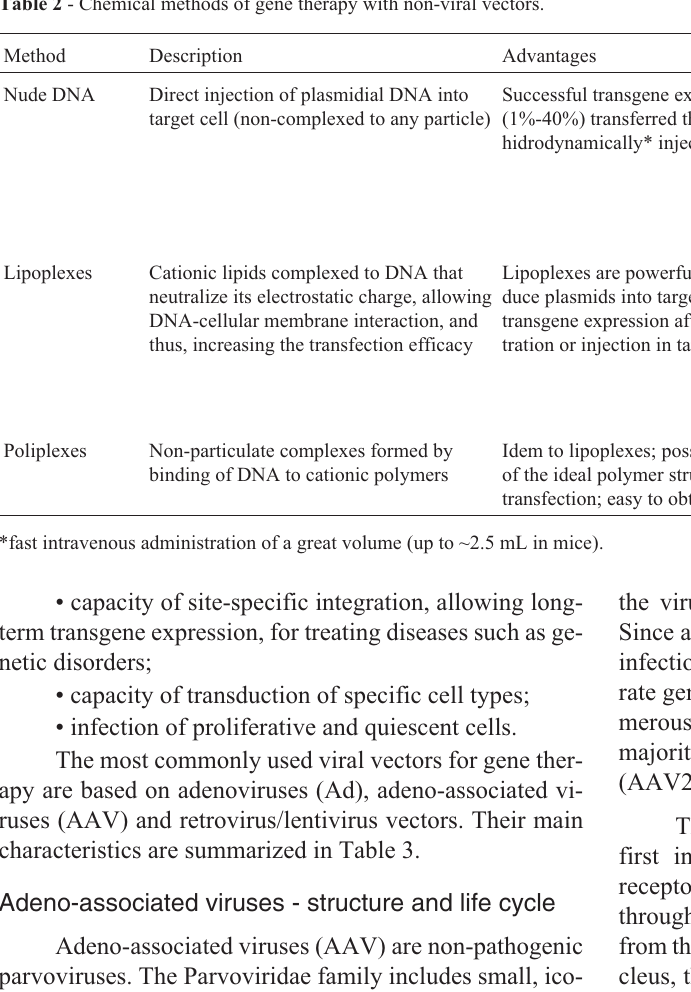
Table 2 - Chemical methods of gene therapy with non-viral vectors.